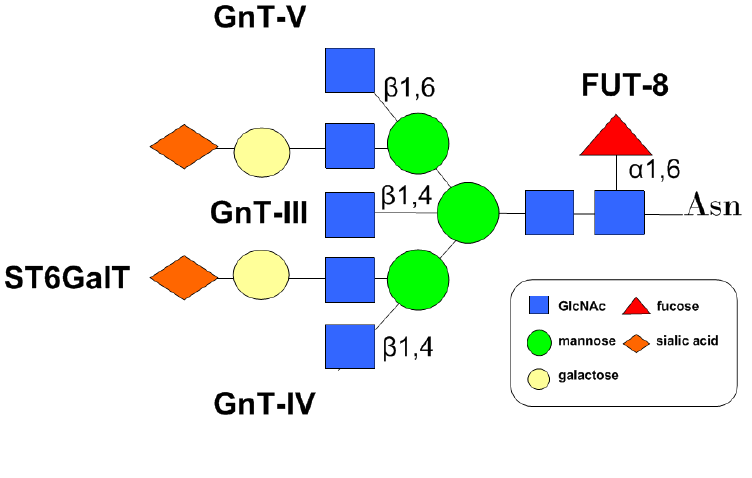
Figure 3. Potential glycan structures of CD147 and corresponding enzymes. In the medial-Golgi compartment, GnT-IV catalyzes β1-4 branch on complex N -Glycan structures, while GnT-III and GnT-V catalyze the formation of bisecting structure and β1-6 branch, respectively. The core fucose structure is catalyzed by FUT8. Then CD147 enters the trans -Golgi apparatus and receives sialic acid modification by sialyl transferase